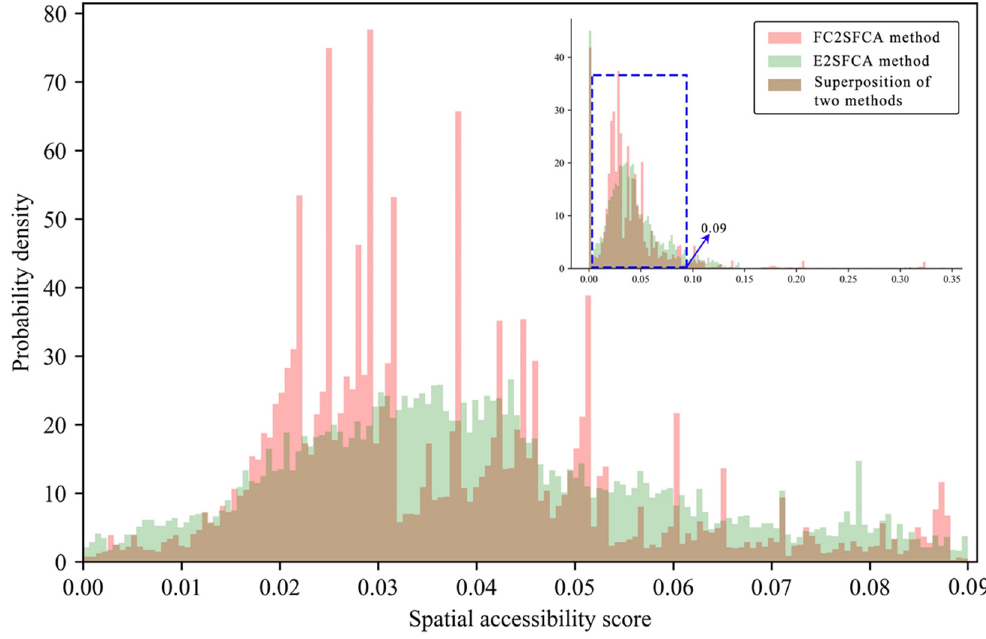
Figure 5. The probability density distribution histogram of the spatial accessibility score of fire incidents.